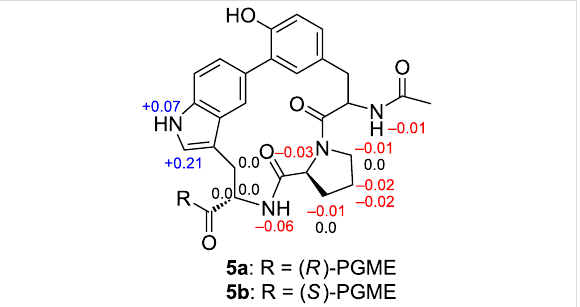
Figure 3: 1 H NMR Δδ S − R values for PGME amides 5a and 5b ob- tained from compound 1